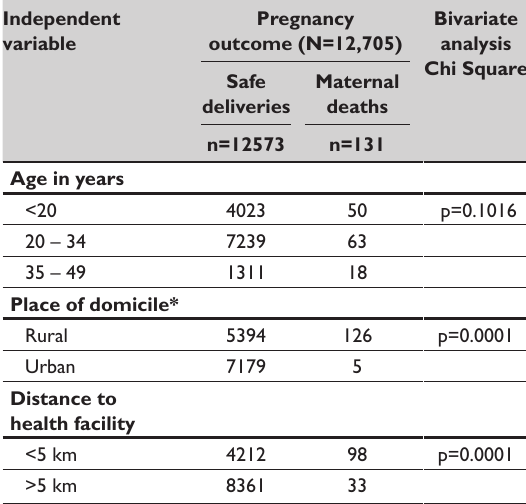
Table 3: Pregnancy outcomes in relation to some bio-socio-demographic factors among 12,573 deliveries, 2010-2014, Kuando Kubango, Angola Independent